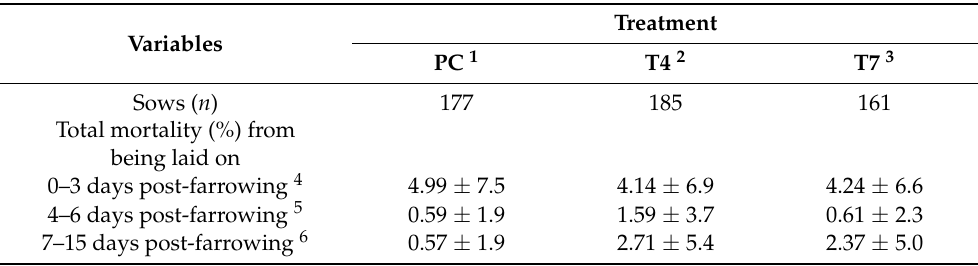
Table 3. Percentage of piglet mortality (mean ± SD) due to being laid on across different periods post farrowing by treatment